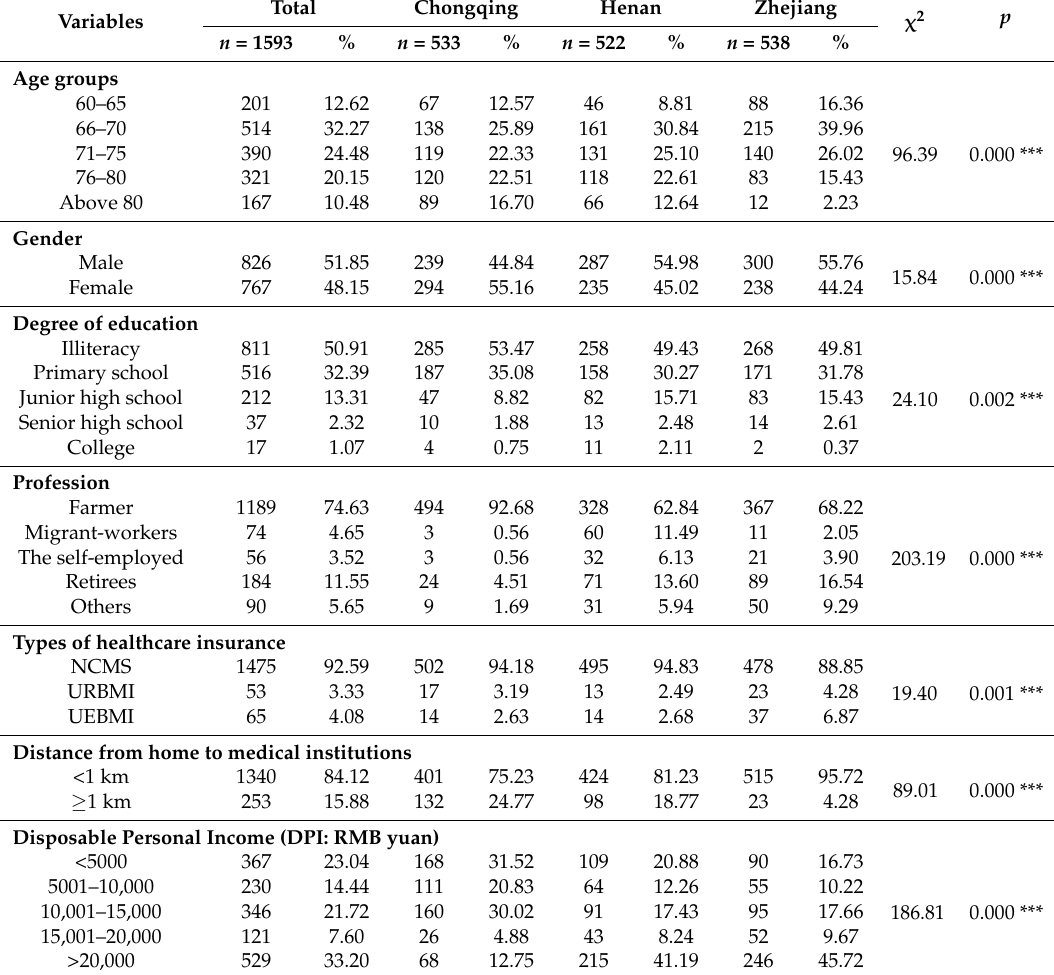
Table 2. Description of the socio-demographic characteristics of the elderly in sample